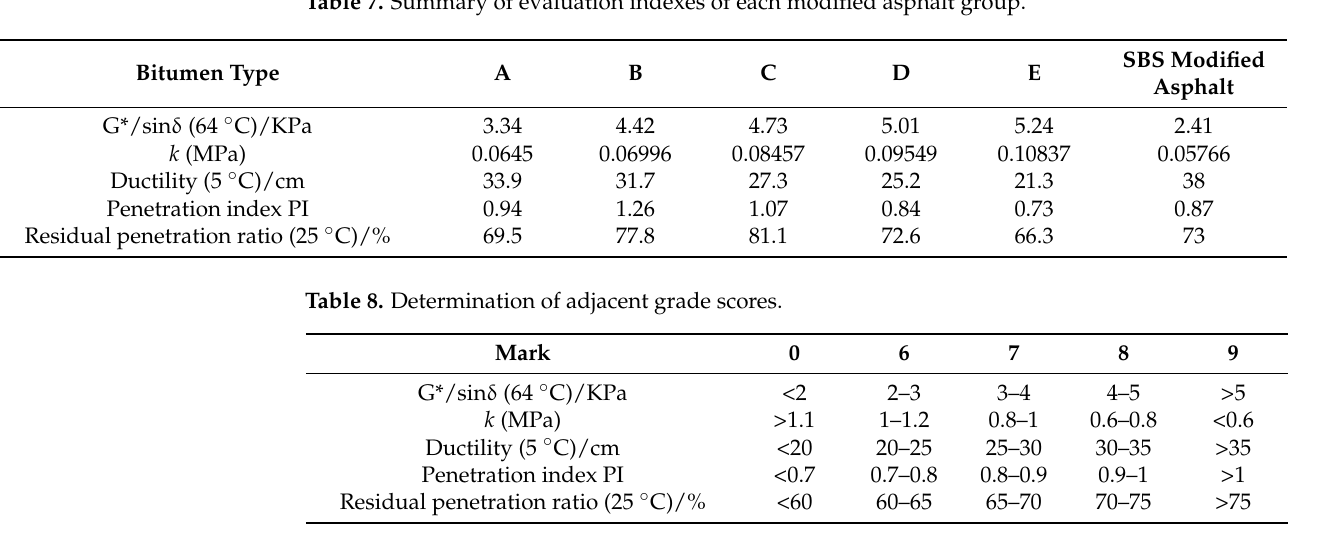
Table 7. Summary of evaluation indexes of each modified asphalt group.